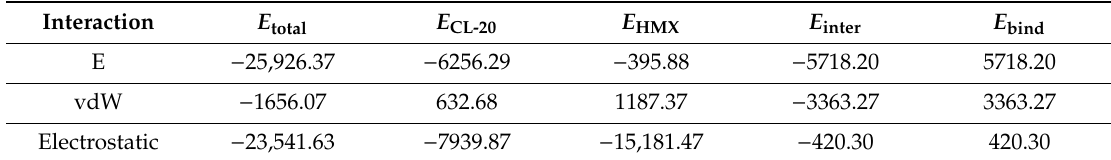
Table 3. The binding energy between each component of CL-20 / HMX mixture, kJ · mol − 1 [2], with permission from Han Neng Cai Liao, 2016.